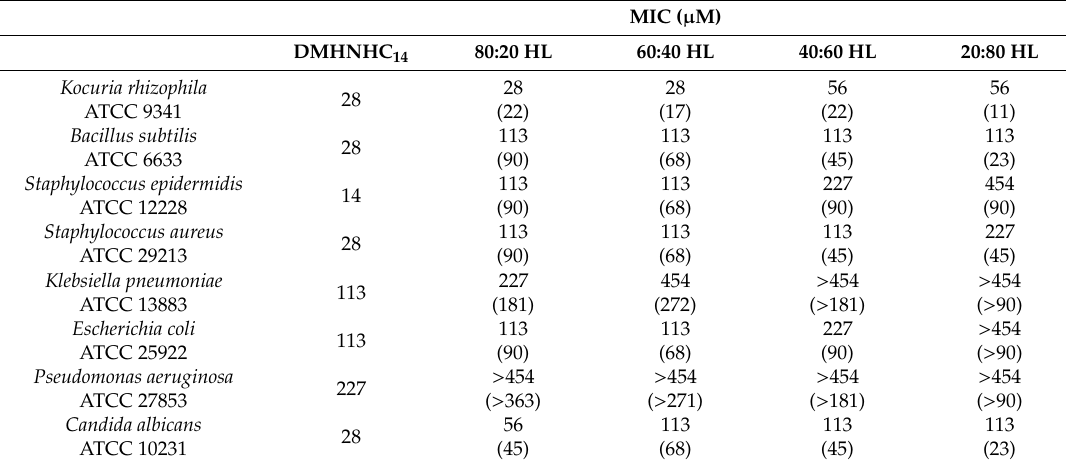
Table 4. Minimum inhibitory concentration (MIC) of the pure histidine derivative and its HL catanionic mixtures. Values in brackets correspond to the concentration of DMHNHC 14 in the catanionic formulations at their MIC values (MIC H ). The MIC values of C 12 C 3 L were higher than 113 µ M for all microorganisms